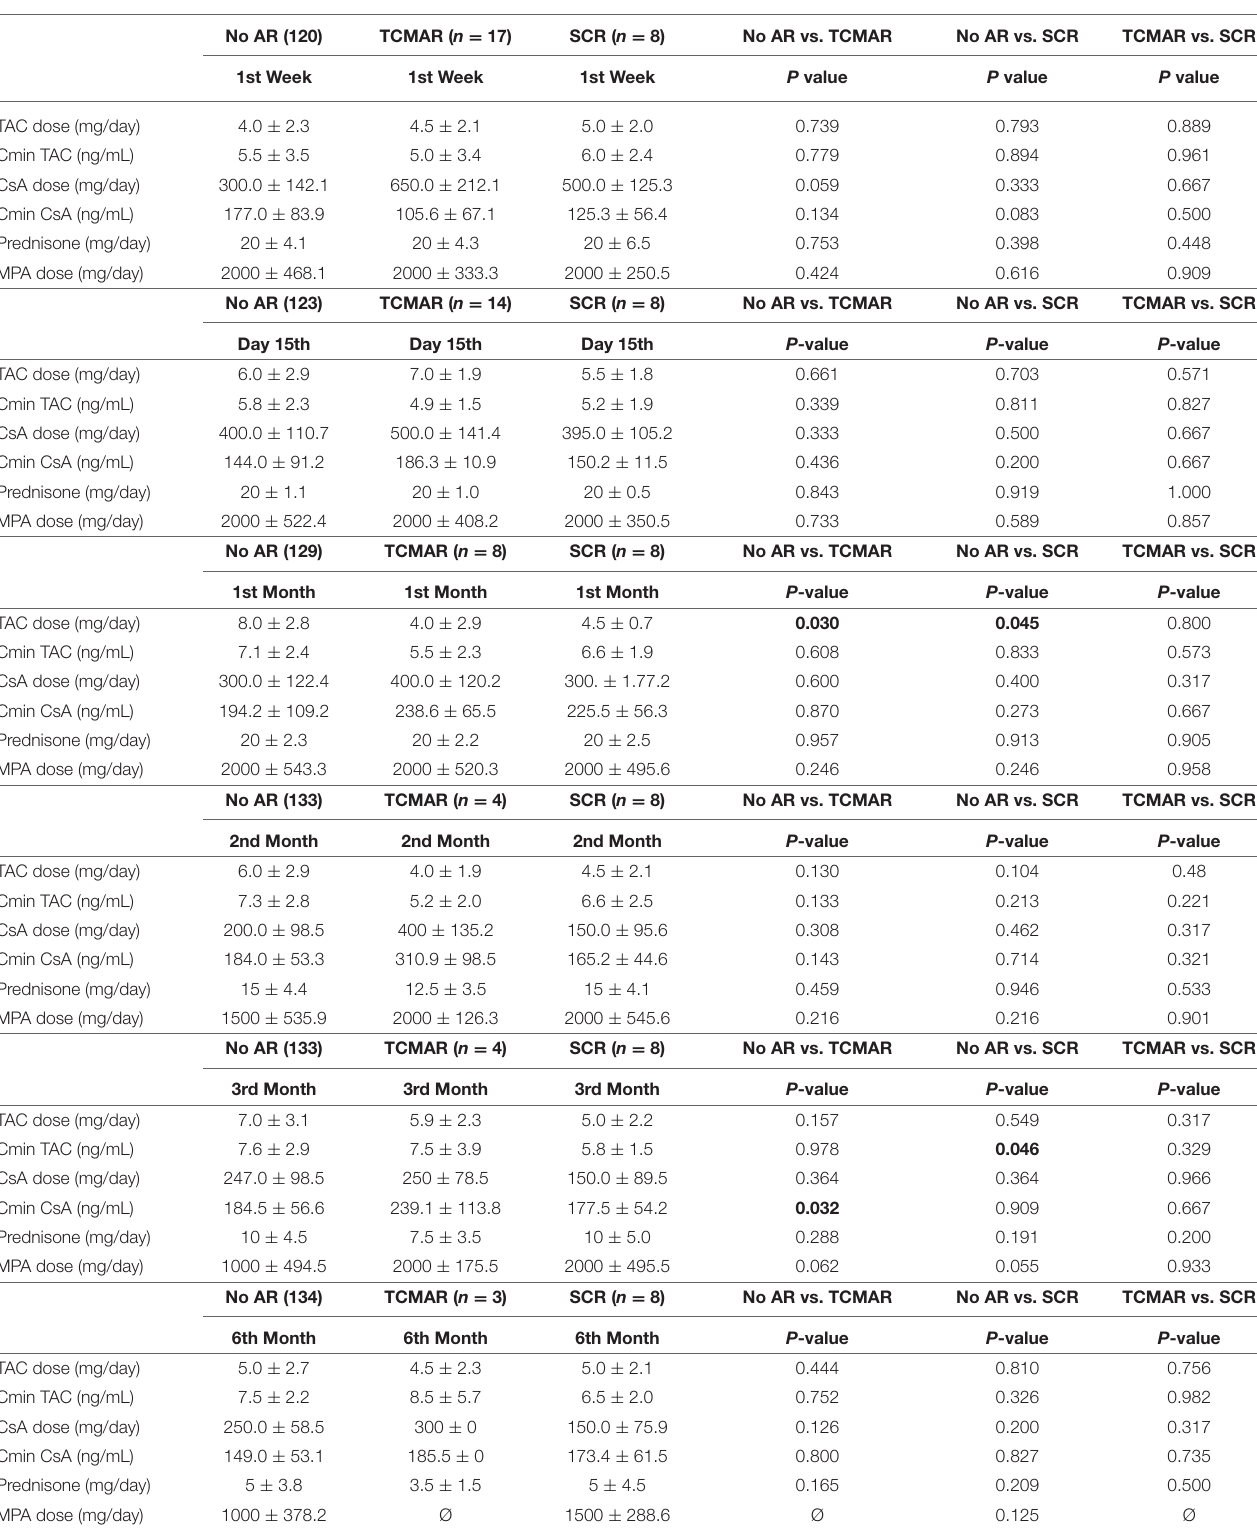
TABLE 2 | Pharmacokinetics